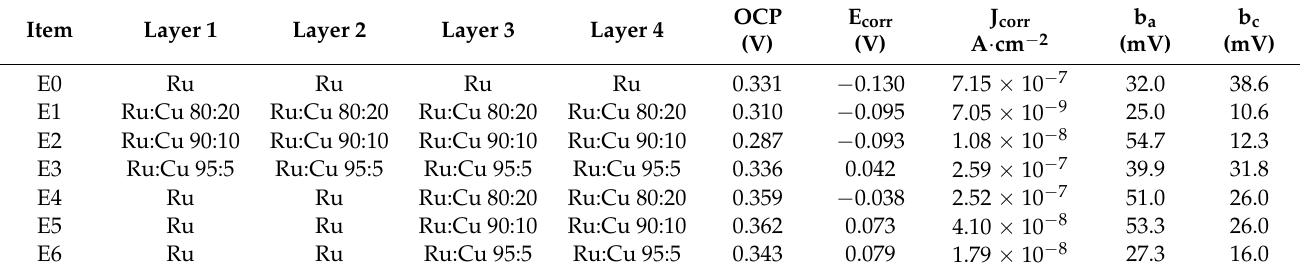
Table 1. Composition and electrochemical data of the prepared